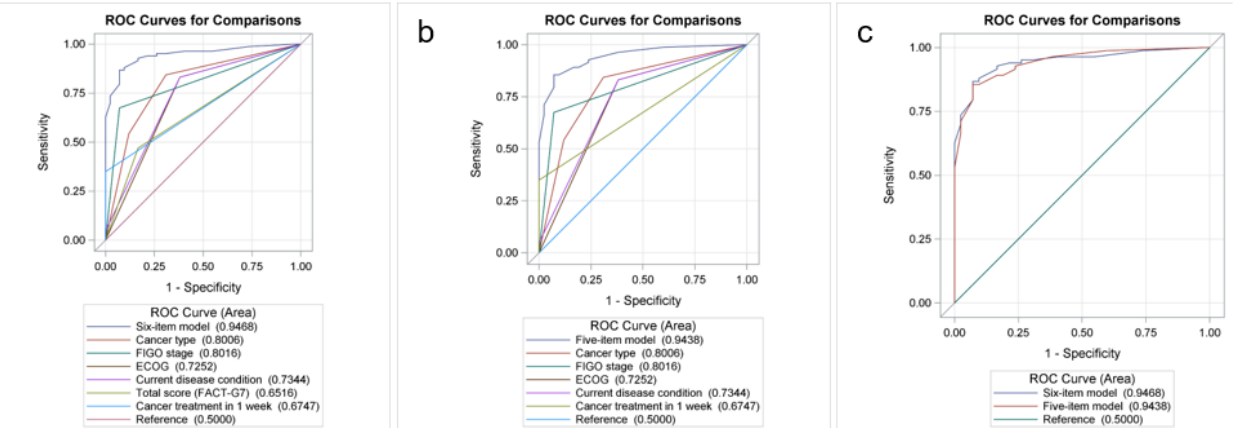
Figure 1. Receiver operating characteristic (ROC) curve and area under the ROC curve (AUC) for predicting the possibility of seeking multiple fatigue-related managements. ( a ) Six-item predictive model. ( b ) Five-item predictive model. ( c ) Comparison between the six-item and five-item models.